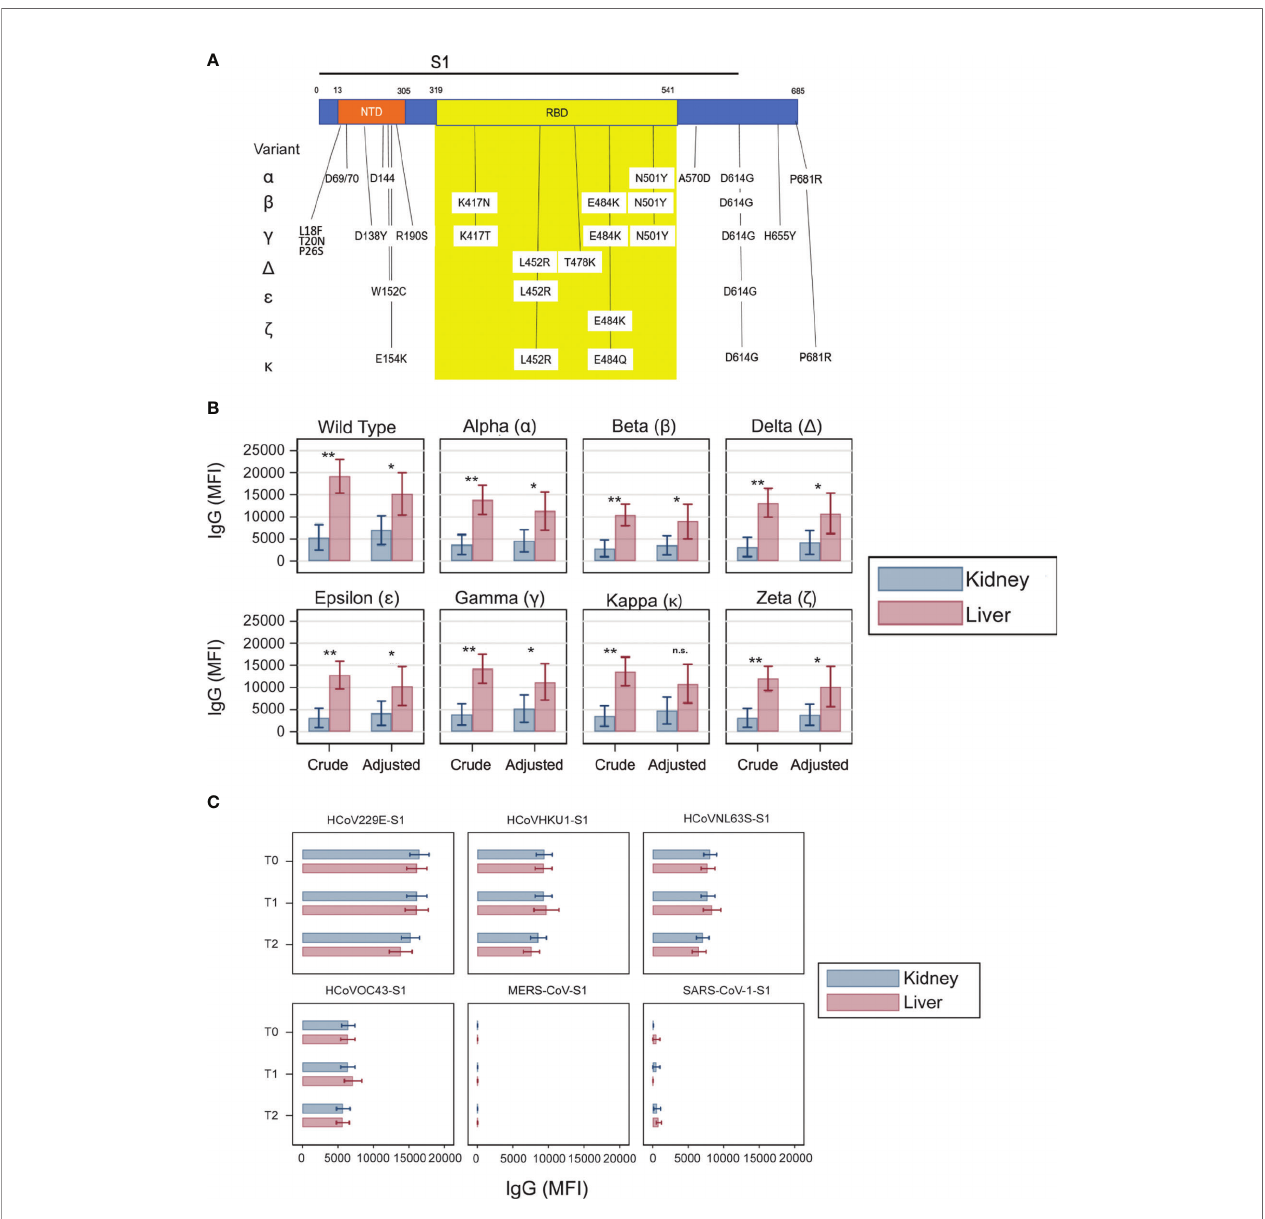
FIGURE 3 | Antibody responses against the SARS-CoV-2 variants and non-SARS-CoV-2 coronaviruses. (A) Schematic of the SARS-CoV-2 S1 region with N terminal domain (NTD) and receptor binding domain (RBD) indicated. Vertical drop downs list the location and amino acid changes from each variant conjugated to the beads. (B) Crude and adjusted levels of IgG anti-RBD in various SARS-CoV-2 variants in kidney (blue) and liver (red) kidney transplant recipients on tacrolimus at T2. Adjusted analysis was adjusted for induction, blood tacrolimus levels, mycophenolate use, and steroid use. Horizontal lines represent 95 percent con fi dence intervals. n.s., not signi fi cant; *P < 0.05, **P < 0.01. (C) Antibody strength directed against the S1 region of non-SARS-CoV-2 coronaviruses. MFI thresholds for positivity: HCoV229ES1: 11,636; HCoVHKU1S1: 6,161; HCoVNL63SS1: 6,392; HCoVOC43S1: 4,888; MERSCoVS1: 27; SARSCoV1: